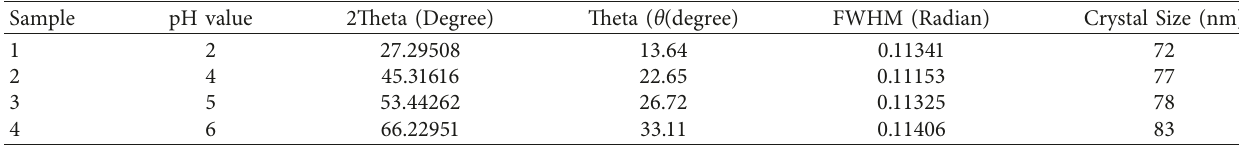
Figure 2: XRD graph of prepared iron doped titanium dioxide at different pH values of (a) pH Table 1: The full width at half maxima (FWHM), average particle size and average crystal values of Fe: TiO 5, and